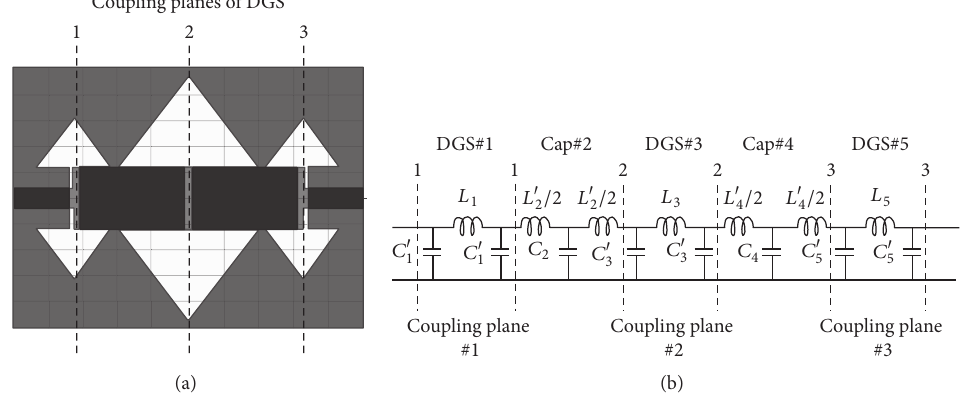
Figure 14: Layout and circuit model of the DGS-based 5-pole LPF. (a) Layout of DGS-based 5-pole LPF with location of coupling plane. (b) Complete circuit model with location of equivalent circuit of DGS